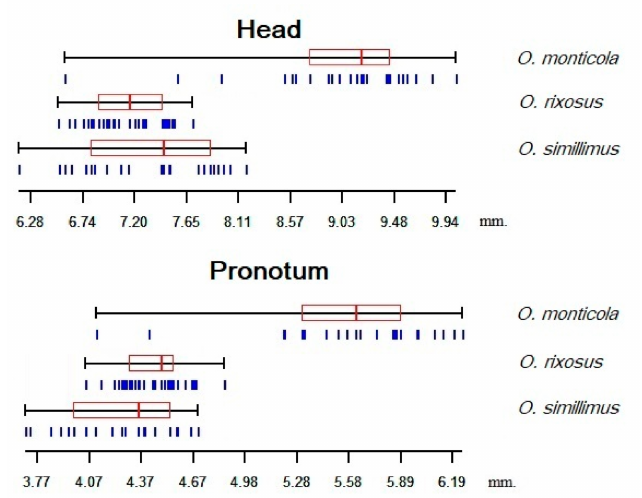
Figure 4. Boxplots illustrating size variations of head and pronotum contours (estimated by the perimeter). Each box represents each ant species and shows the group median that separates the 25th and 75th quartiles.